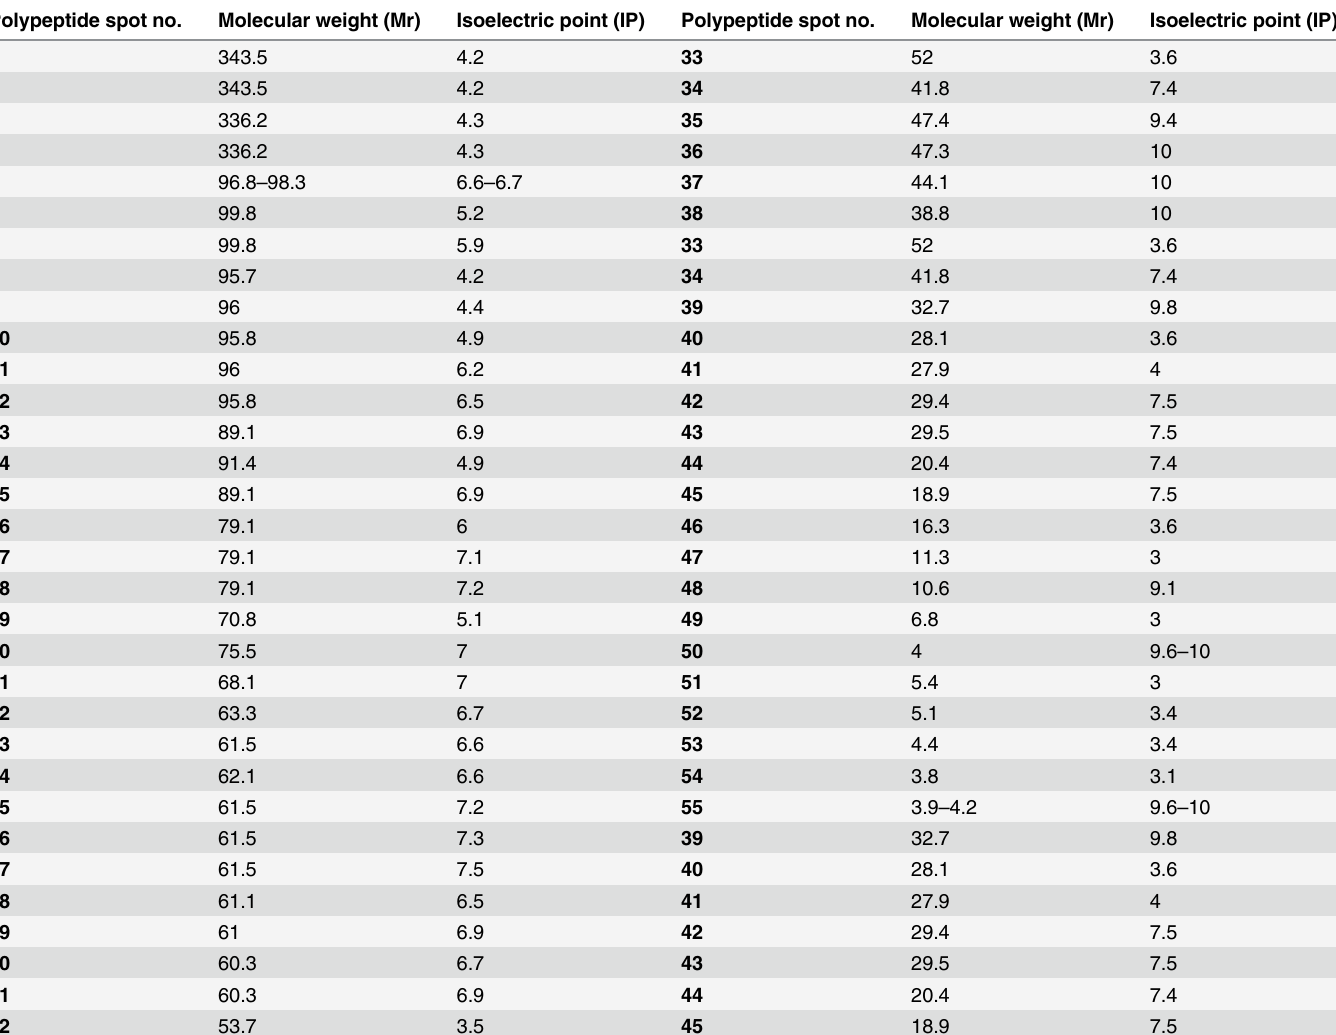
Table 4. T . gondii strain RH tachyzoite proteins (Fig. 8). Polypeptide spot no.